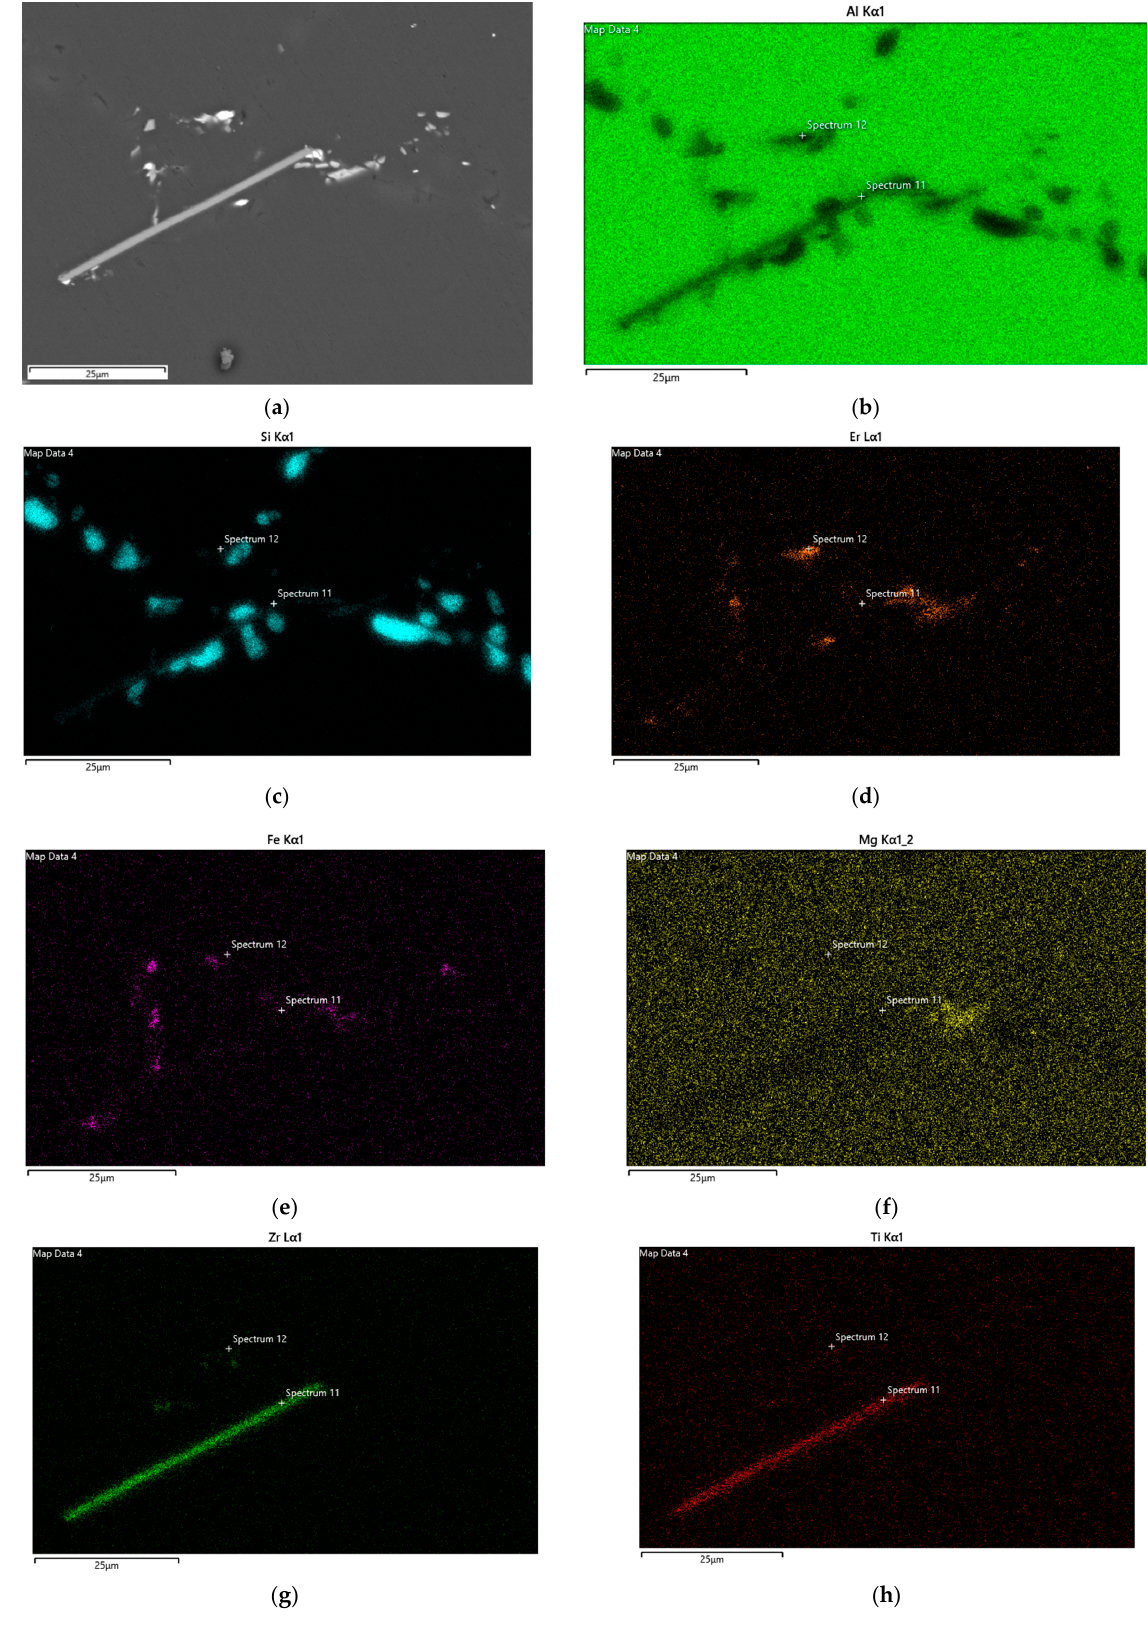
Figure 9. SEM BSE micrograph ( a ) and corresponding EDS map for the alloying elements (Al ( b ), Si ( c ), Er ( d ), Fe ( e ), Mg ( f ), Zr ( g ) and Ti ( h )) in a sample of EZ353 alloy hold for 100 h at 300 °C. Table 2. Chemical composition (at%) in points identified as 11 and 12 in maps of Figure 9.